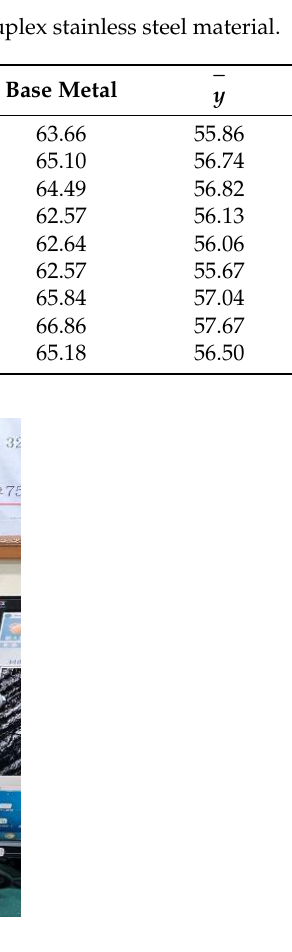
Figure 3. Vickers hardness values of welded specimens. Table 5. Vickers hardness values were measured in the duplex stainless steel material. Unit: MPa.